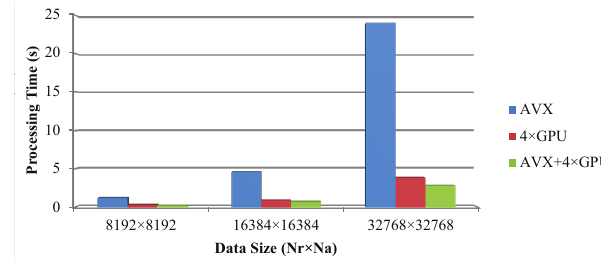
Figure 11. The performance comparison among three HPC